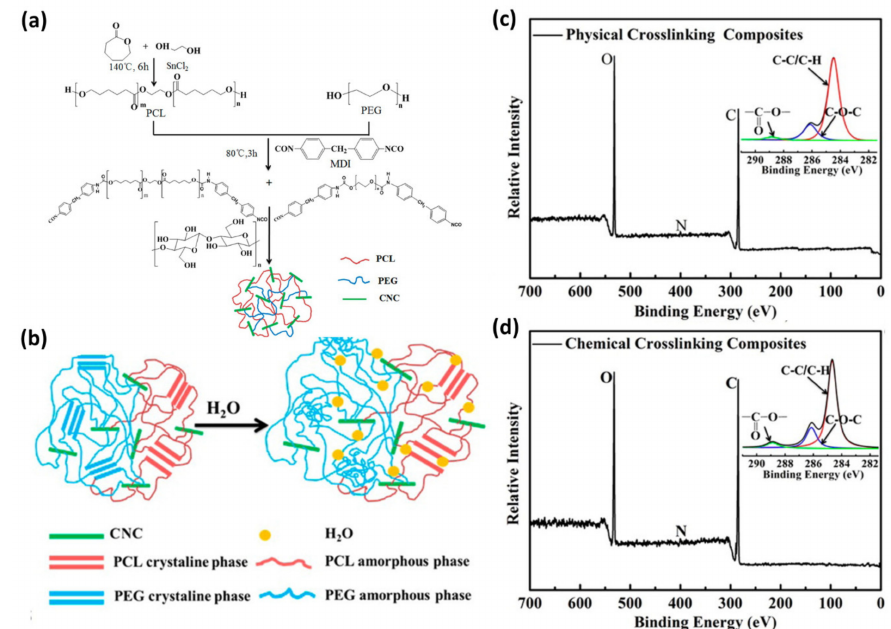
Figure 4. Shape memory process of PEG-PCL-CNC thermo-responsive nanocomposite. ( a ) The scheme showing the synthetic route for the PEG-PCL-CNC nanocomposite. ( b ) Shape memory mechanism of the PEG-PCL-CNC nanocomposite water responsiveness. XPS survey spectra of the ( c ) physically cross-linked nanocomposite and ( d ) chemically cross-linked nanocomposite PEG(60)-PCL(40)-CNC(10) (inset images show C(1s) multiplex spectra) (Reproduced with permission from Reference [33]; Copyright (2015) American Chemical Society).